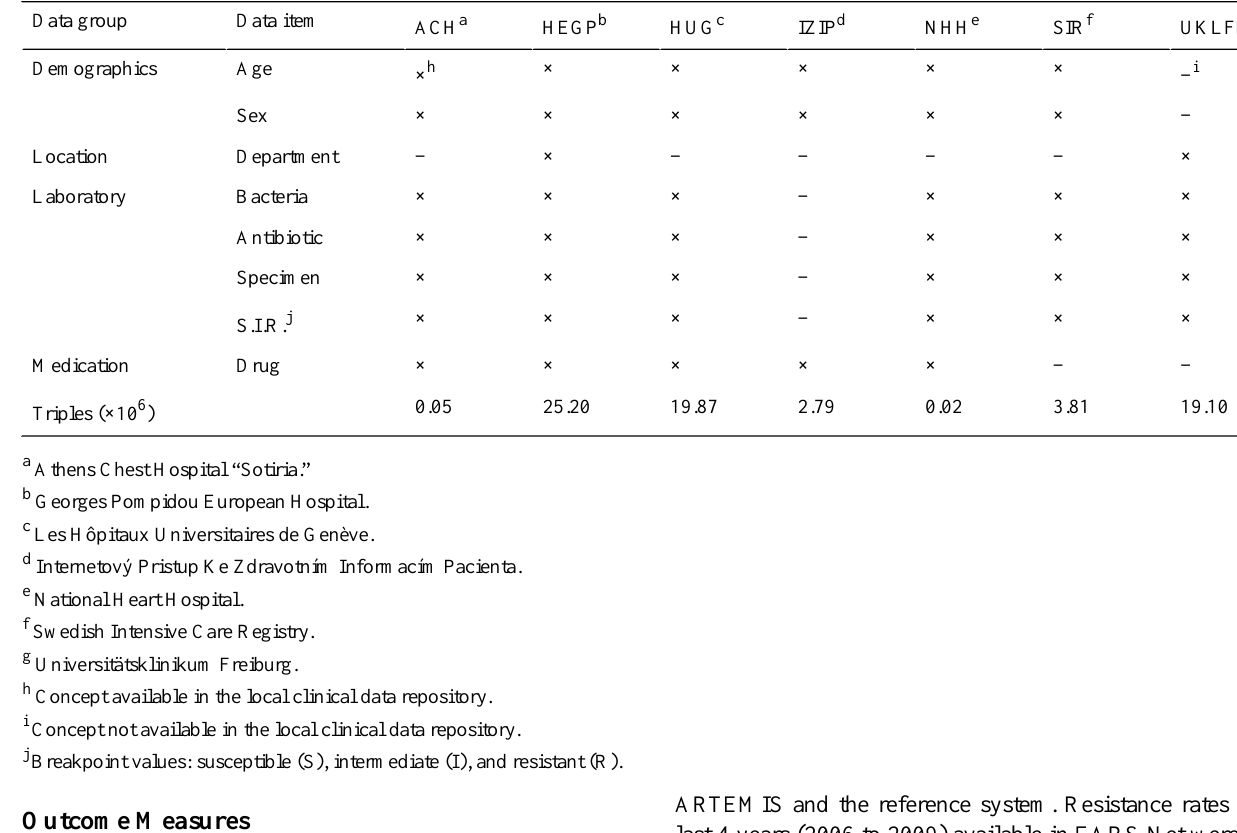
Table 1. Data used in the Antimicrobial Resistance Trend Monitoring System